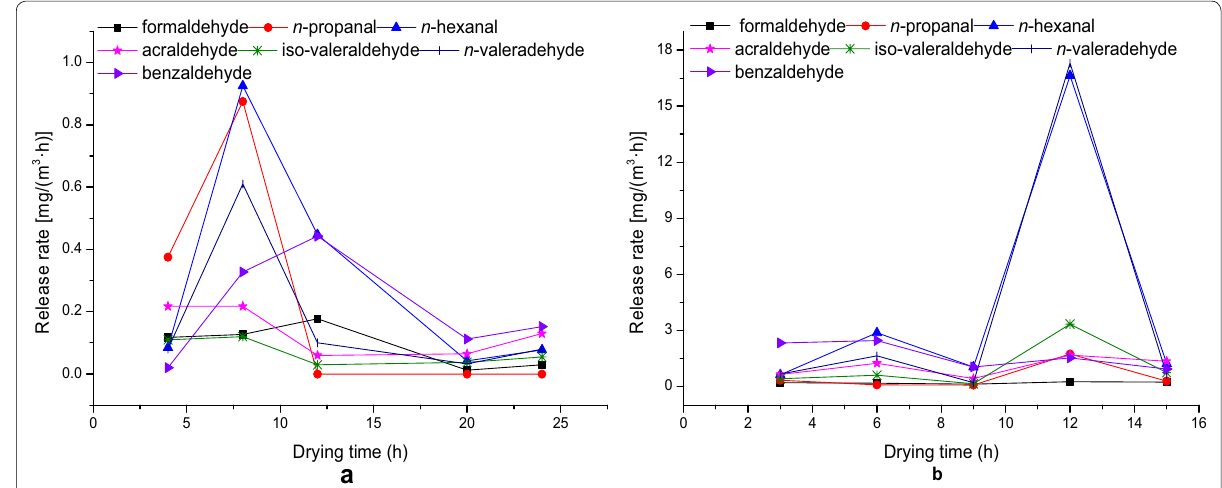
Fig. 6 Variations of release rate of aldehyde VOCs during a conventional drying, and b high-temperature drying for the Russian Pinus sylvestris